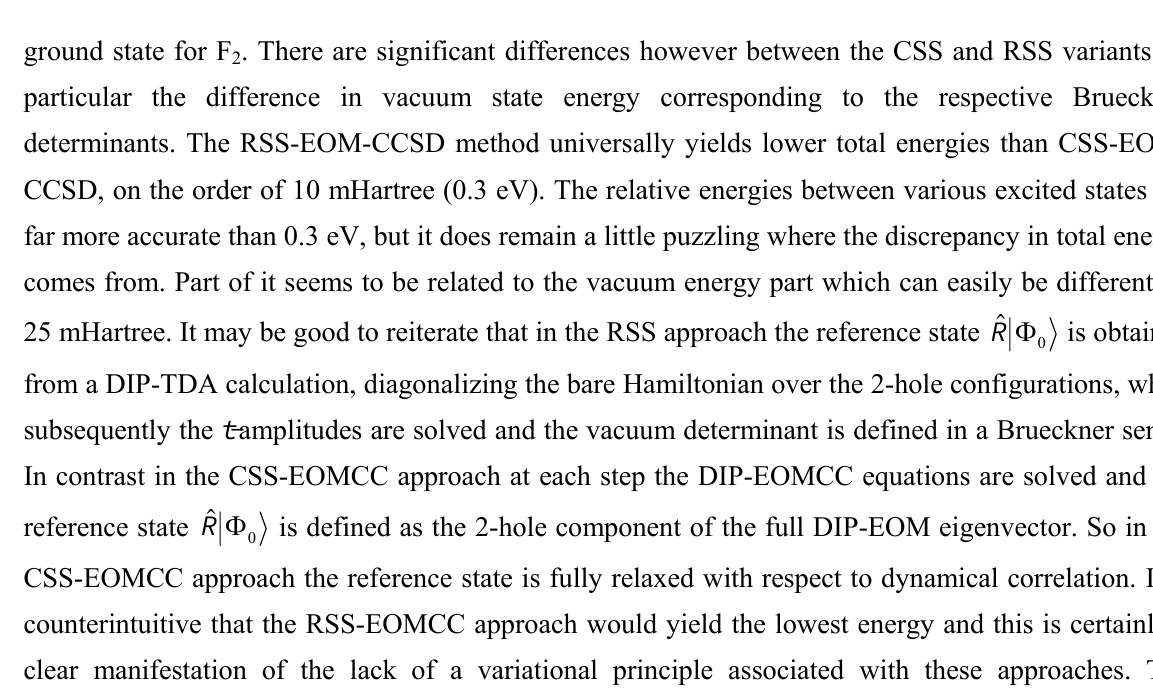
molecule at 121 pm. and 2